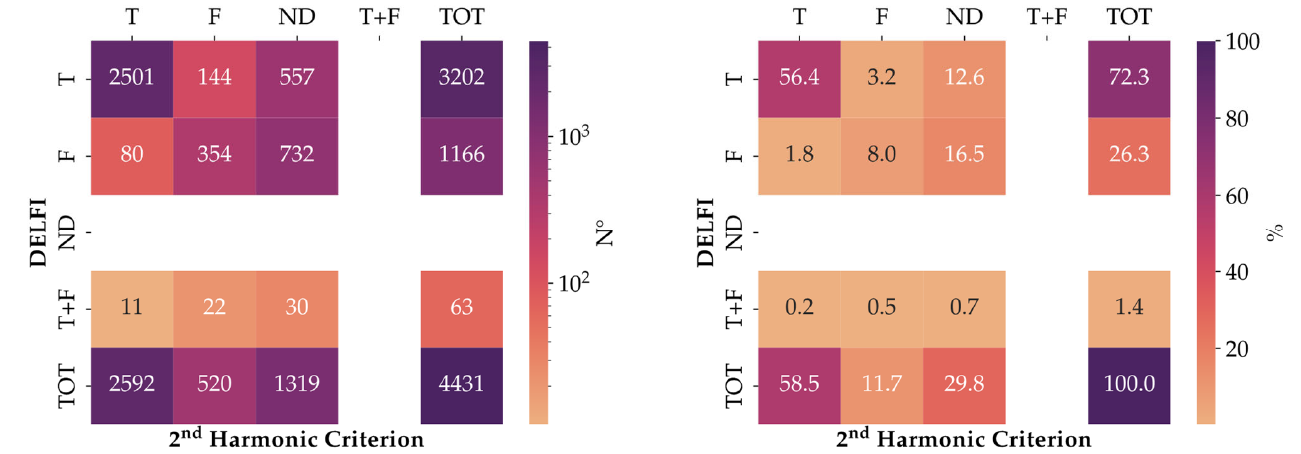
Figure 11. Validity assessment: 2nd Harmonic and DELFI outcomes for the IN Subset.